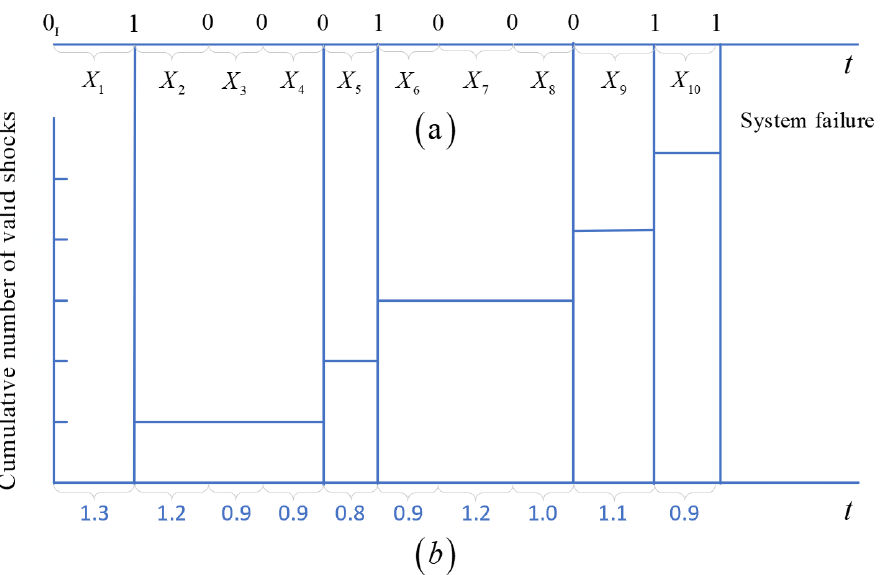
Figure 2. Failure process of the system under self-exciting trigger mechanism 2. (a denotes the type of shock and b denotes the shock occurrence time)